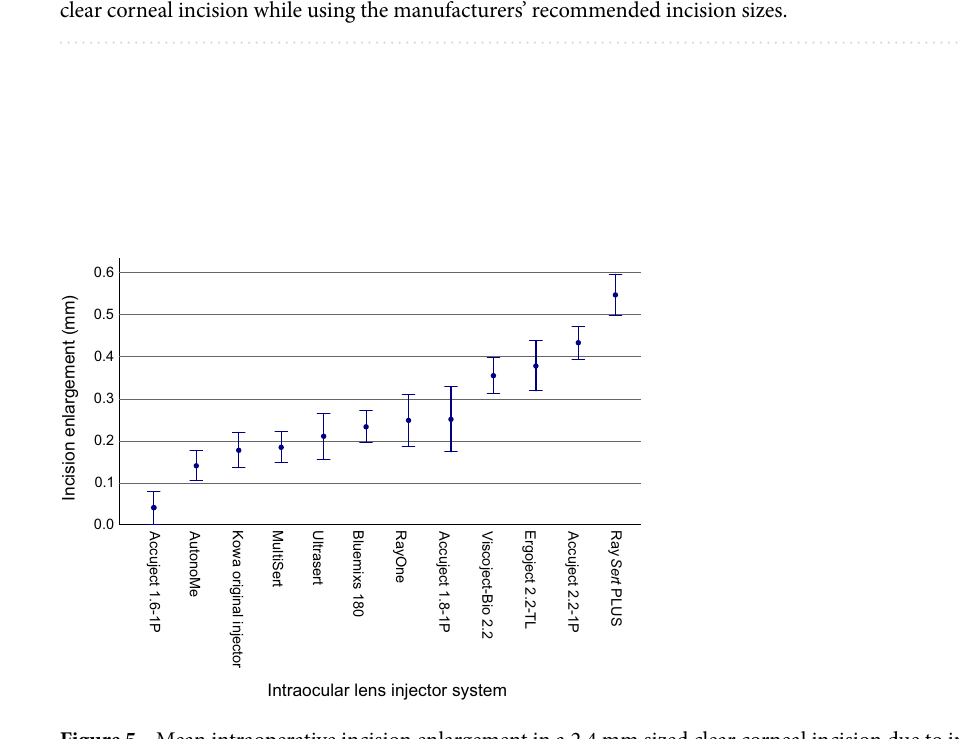
Figure 5. Mean intraoperative incision enlargement in a 2.4 mm sized clear corneal incision due to intraocular lens injector insertion. The error bar represents a 95% confidence